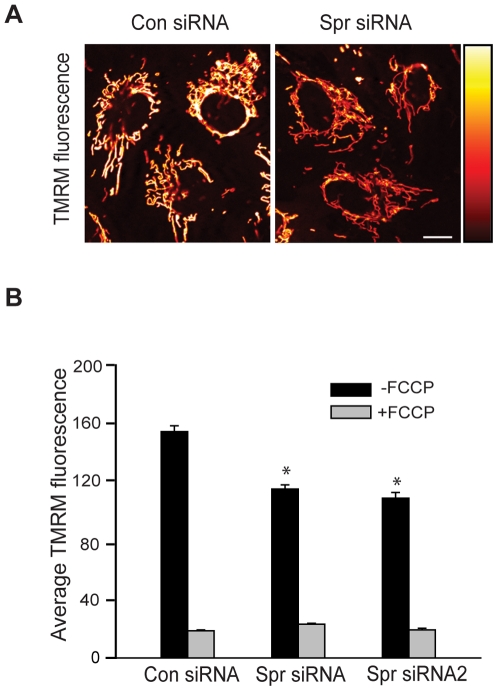
Spartin depletion causes depolarization of mitochondrial membrane potential.(A) Representative images showing TMRM fluorescence in SK-N-SH cells treated with control (left panel) or spartin siRNA (right panel). The pseudocolor bar represents an intensity scale, with black as minimum and bright yellow as maximum intensity. (B) The graph shows the average pixel fluorescence intensity of TMRM in cells treated with control or spartin siRNA. Cells were either treated or not treated with FCCP as indicated. The data represent mean ± S.E.M in 150 cells for each condition from three independent experiments (*p>0.01).